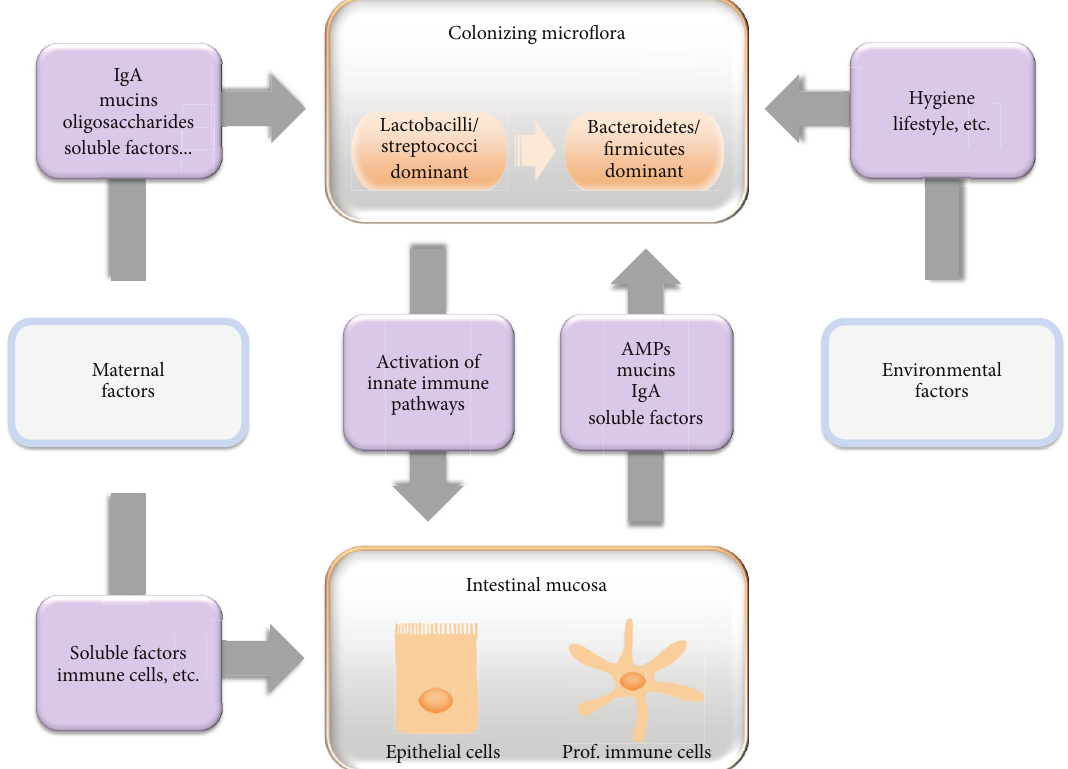
Figure 2: Factors involved in postnatal intestinal innate immune adaptation. The colonizing microflora and the intestinal mucosa interact in a two-way street to establish life-time tolerance and mutualism between each other. While bacteria activate innate immune pathways in host epithelial and immune cells inducing immune maturation and tolerance, mucosal cells produce factors (antimicrobial peptides AMPs, mucins, immunoglobulin A IgA, etc.) to control the number and the composition of bacteria. Microflora is also influenced by environmental factors (hygiene, lifestyle, etc.). Maternal factors, such as IgA, mucins, oligosaccharides, or other soluble factors, can modulate the microflora, and contribute to improve host immune defense and maturation (maternal immune cells, soluble factors,